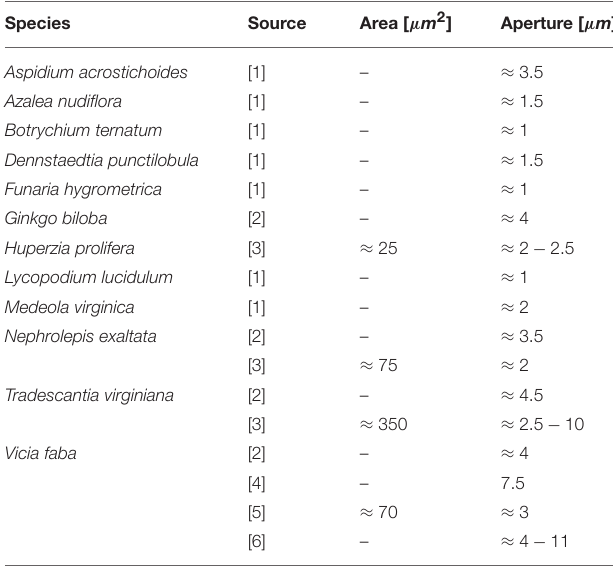
TABLE 1 | Experimental data from literature for the opening area and aperture of stomata of various plant species, adapted for the geometrical definitions in Figure 5